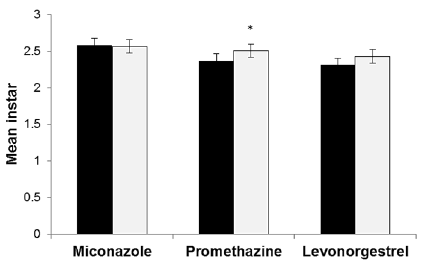
Figure 1. Development and mean instar. Mean instar (with 95% confidence intervals) for the 2-d incubation (n=10). Test concentrations were 0.0023 mg L 2 1 for miconazole, 0.059 mg L 2 1 for promethazine and 1.02 mg L 2 1 for levonorgestrel. Black bars represent controls and white are the treatments. Asterisk indicates significant level: p # 0.05 (*) determined by an unpaired